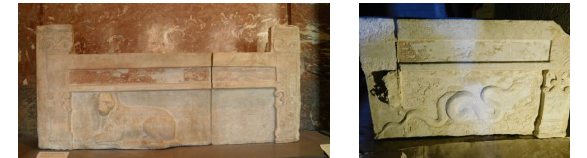
Figure 5: The burial beds with the depictions of a dog (left) and a snake (right) Figure 6: Macridy Bey (top) in front of the burial chamber in